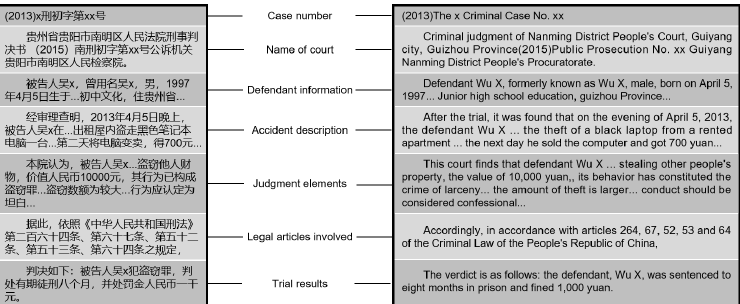
Figure 1. Adjudication documents’ structure. On the left is the structure of Chinese adjudication documents, and on the right is its English